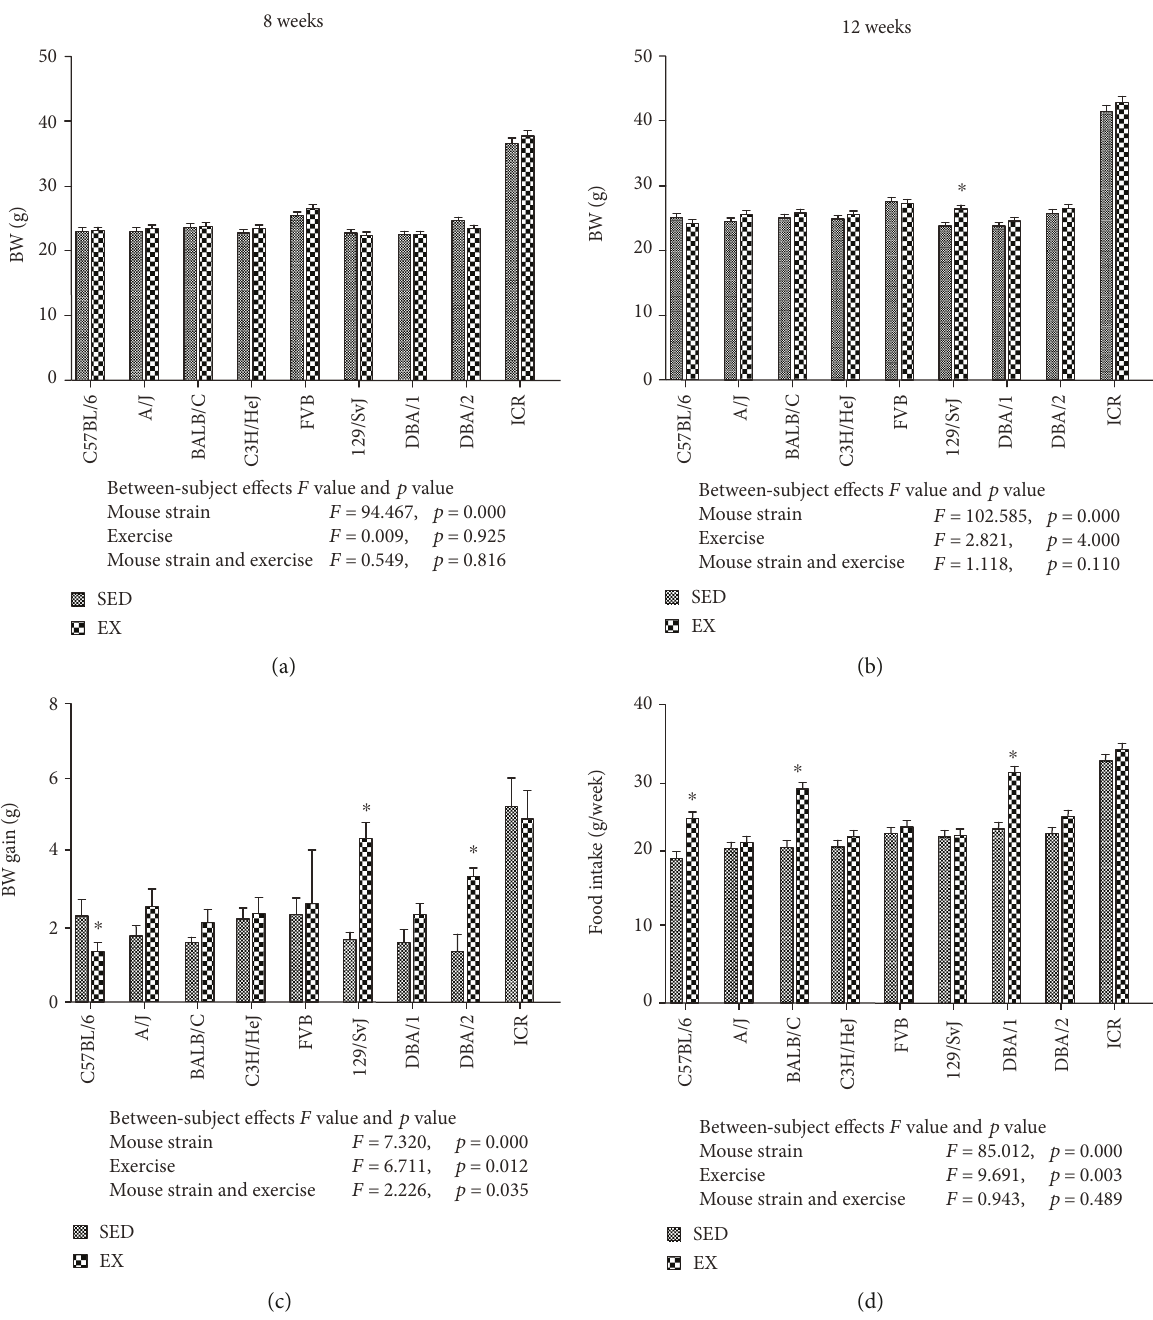
Figure 2: Body weight at the beginning (8 weeks of age) (a) and end (12 weeks of age) (b) of exercise and its control group ( n = 5 per group). Body weight gains analysis was determined by calculating the di ff erence in body weight at 12 weeks and 8 weeks (c). Food intake was calculated from the mean intake during the 4-week experimental period and expressed as g/mouse/week (d). F value and p value of between-subjects e ff ects in mouse strain, exercise, and mouse strain and exercise showed in under the graph. ∗ indicates a signi fi cant di ff erence between the sedentary and exercise groups ( p < 0 05 ); data are shown as mean ±